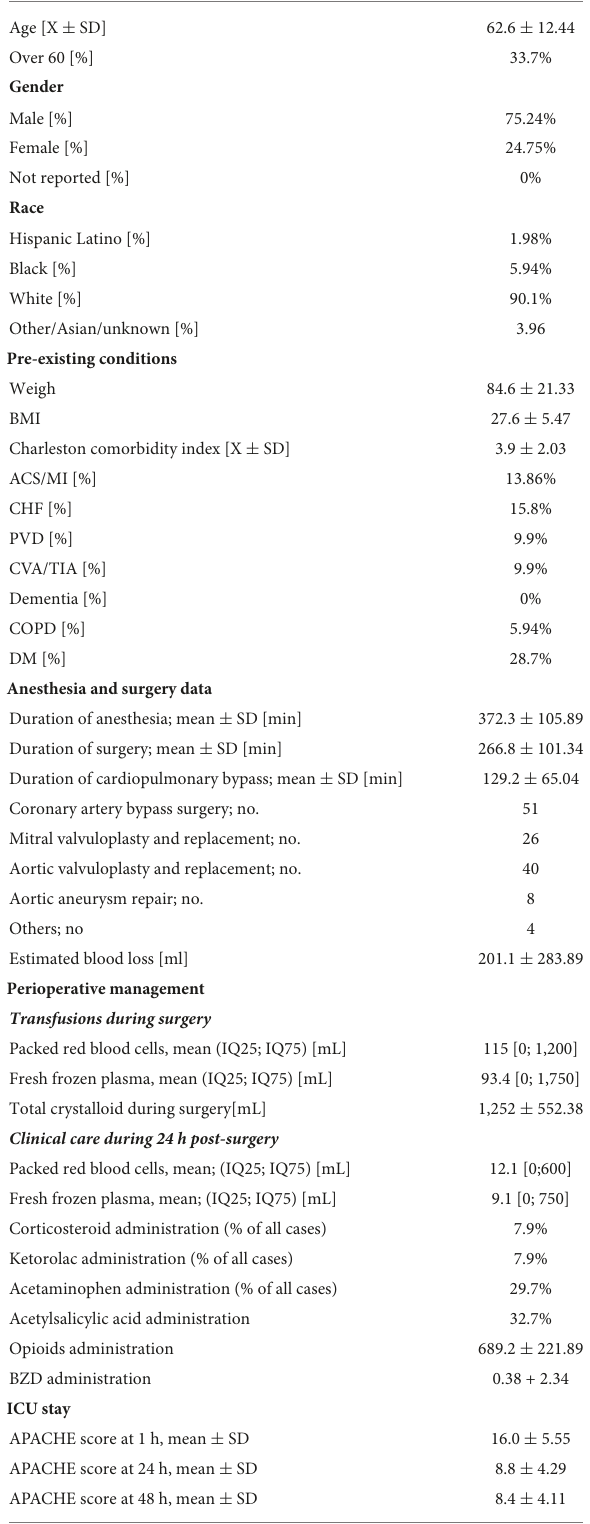
TABLE 1 Demographical and clinical characteristic of the studied